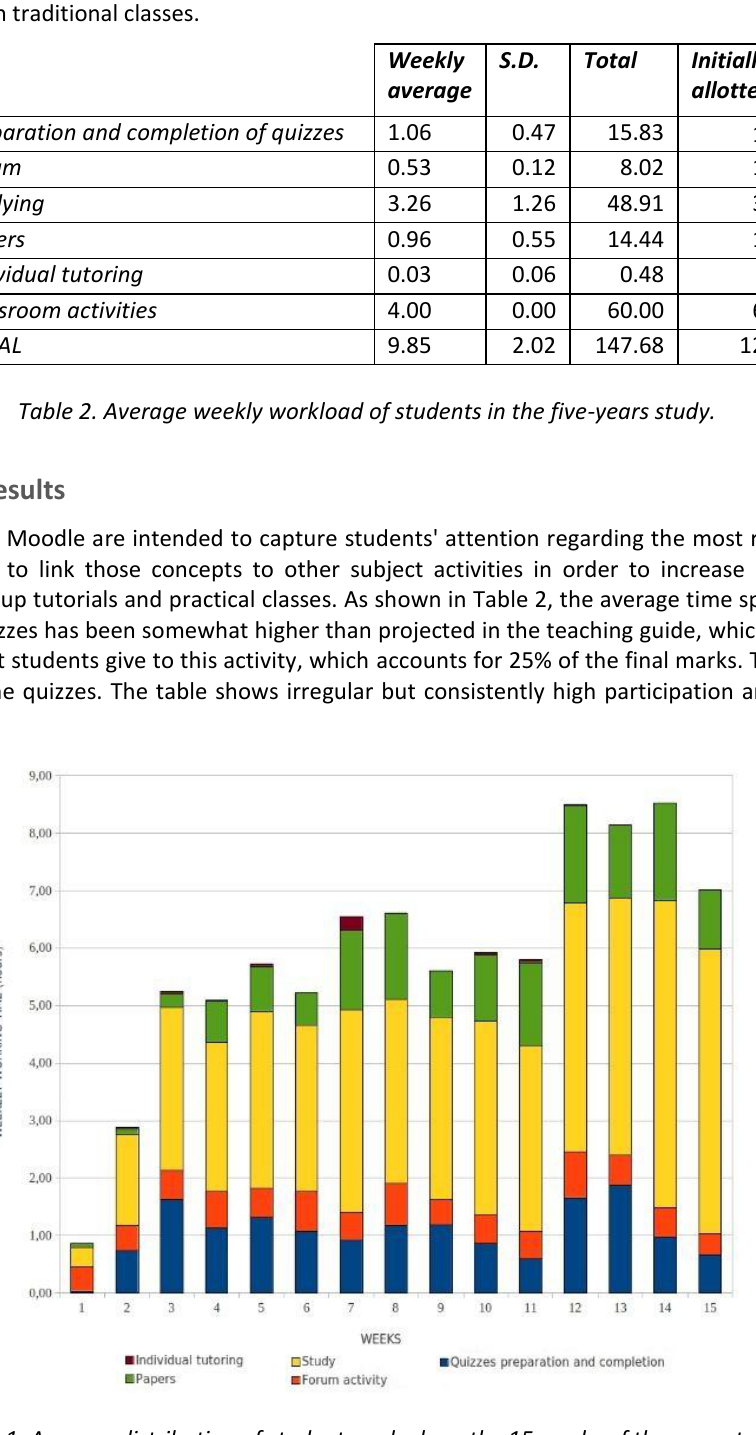
Fig. 1. Average distribution of student work along the 15 weeks of the